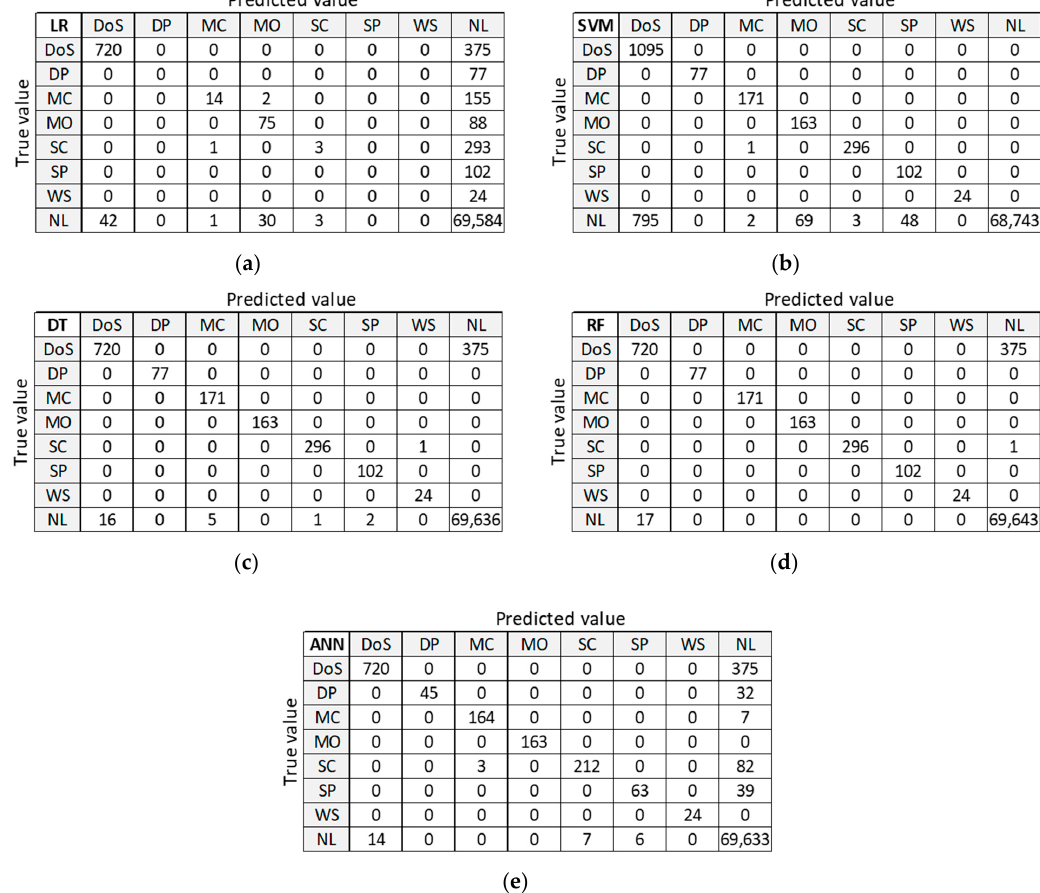
( b ) Figure 11. Accuracy measure for ML algorithms on balanced training datasets DRi : ( a ) training accuracy (coincidence of RF, SVM, and DT); ( b ) test accuracy (coincidence of RF and DT).